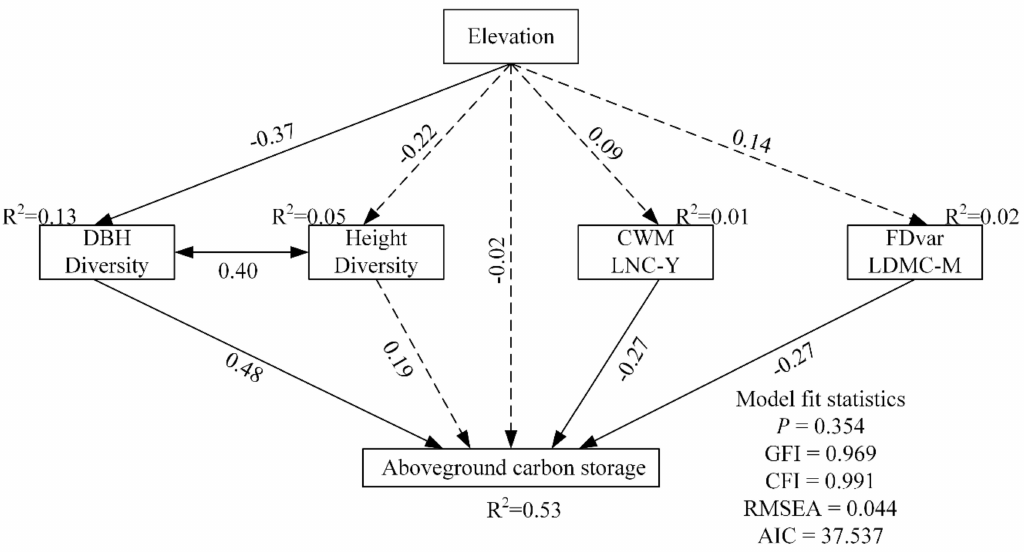
Figure 4. Optimal structural equation model relating aboveground carbon storage to predictor variables. Model-fit statistics and standardized regression coe ffi cients of each path are shown in the figure. Significant and nonsignificant routes at the level of 0.05 are represented by solid arrows and dashed arrows, respectively. The total variation of the explained variable is shown as R 2 , which is explained by all explanatory variables. CWM, community-weighted mean; LNC-Y, young leaf nitrogen concentration; DBH diversity, diameter at breast height diversity; FDvar, functional diversity; LDMC-M, mature leaf dry matter